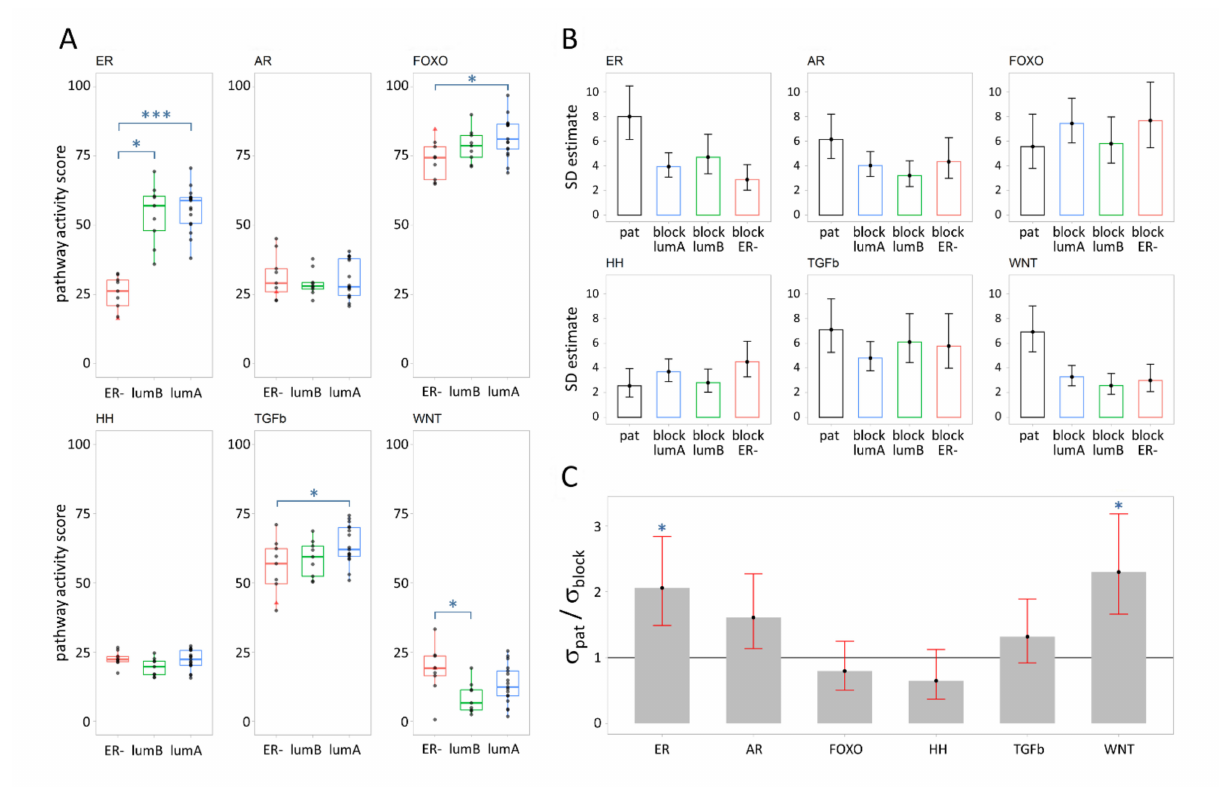
Figure 3. Variation in signaling pathway activity score per breast cancer subtype in the tissue block samples of sample sets I and II. ( A ) Distribution of scores for Luminal A (lumA), Luminal B (lumB), and HER2-positive/triple negative breast cancer (ER − ). Each point represents the average pathway activity score across all tissue block samples of a patient. The HER2-driven patient sample is depicted as a small red triangle. Tukey adjusted significance levels of pairwise test for equality of means are indicated (***: p < 0.0001, *: p < 0.05, values in Supplementary Materials Statistics, Table S1). ( B ) Estimated standard deviation (SD) with corresponding 95% confidence intervals (95% CI) of signaling pathway activity scores describing the heterogeneity in activity scores between all patients, irrespective of subtype (pat) and within a single tumor for tumors in a specific breast cancer subtype (block lumA, block lumB, block ER − ), based on pathway activity scores of primary tumor tissue block samples (values in Supplementary Materials Statistics, Table S3). ( C ) Estimated ratios of between patient SD to within tumor SD ( σ pat / σ block ) with corresponding 95% confidence intervals for subtype-independent σ block model. Significance levels are indicated (*: p < 0.05, values in Supplementary Materials Statistics, Tables S4 and